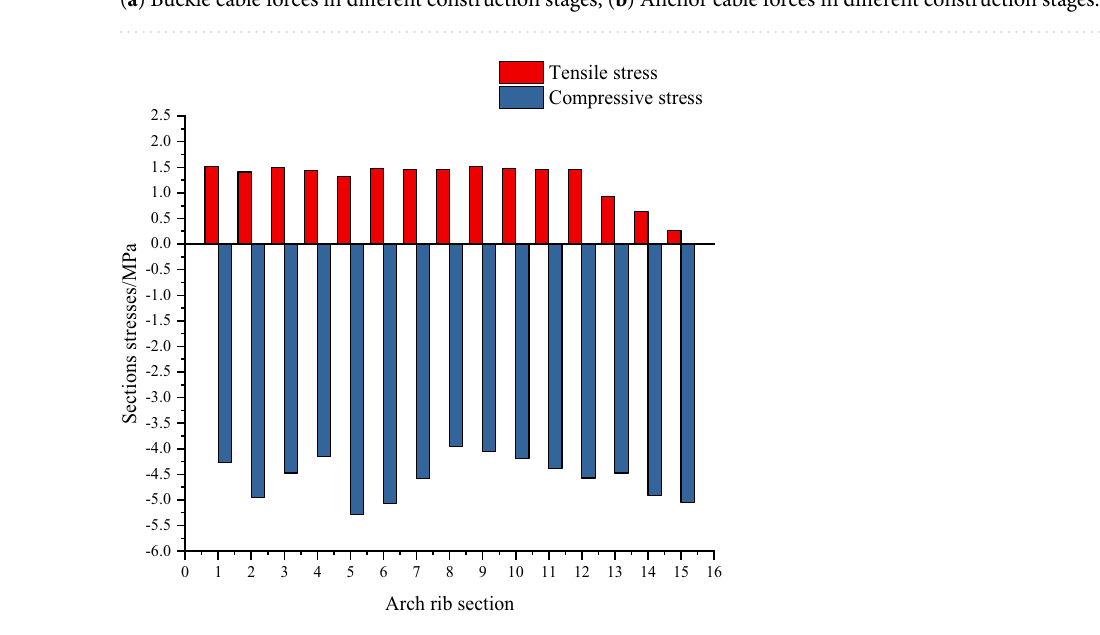
Figure 20. Comparison of cable forces between calculation and measurement in different construction stages: ( a ) Buckle cable forces in different construction stages, ( b ) Anchor cable forces in different construction stages.